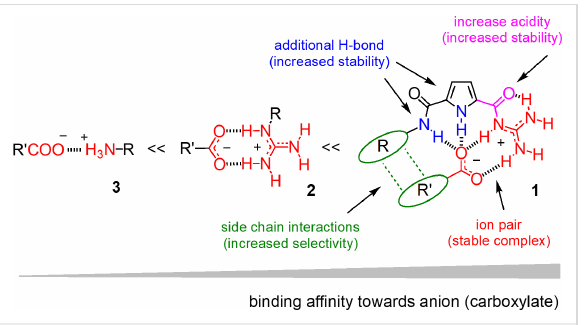
Figure 1: Schematic representation of binding models between organic cations (simple ammonium, guanidinium, Schmuck cation) and oxoanions.